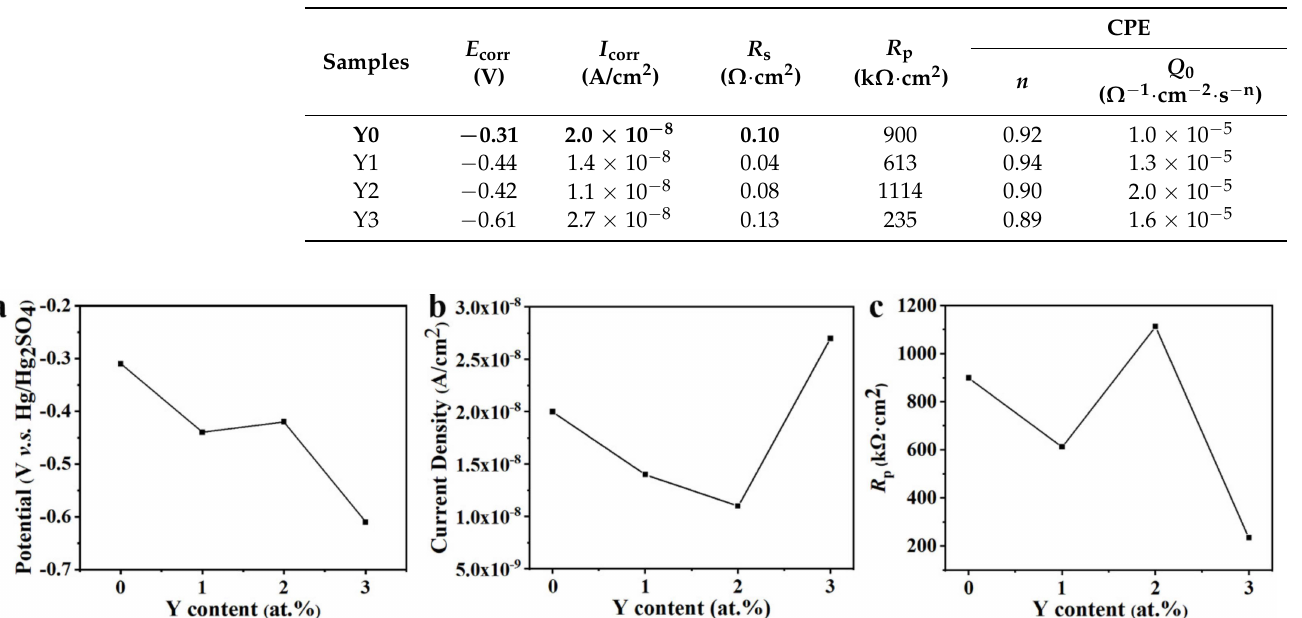
Table 4. Tafel fitting and EIS fitting results of the Y0, Y1, Y2 and Y3 samples.